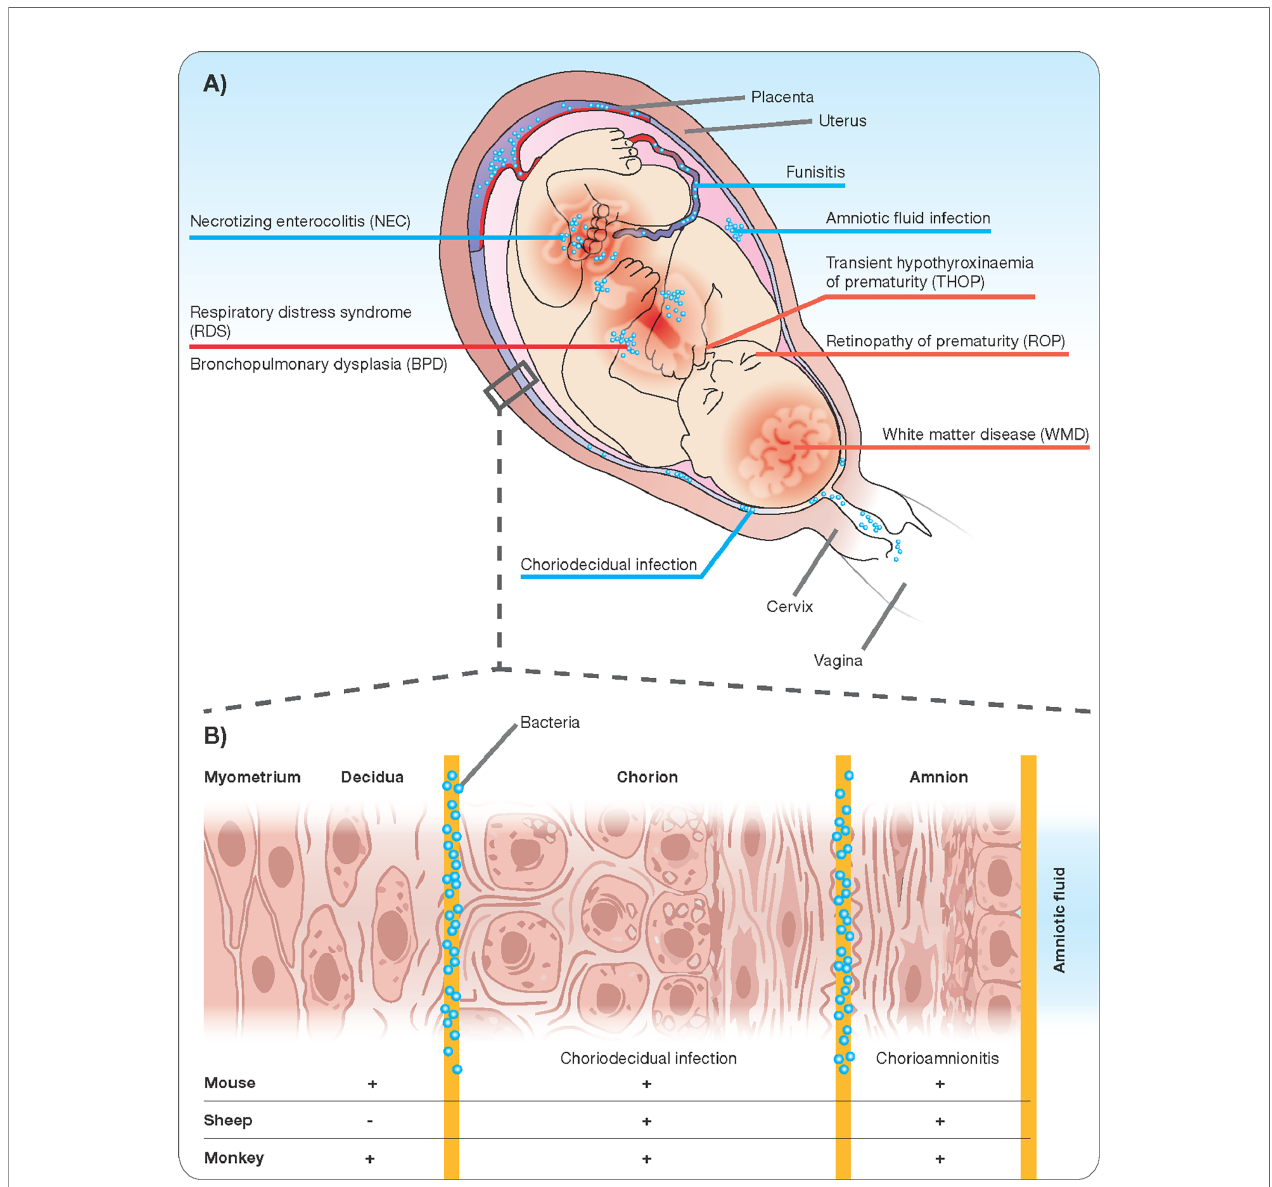
FIGURE 1 | Chorioamnionitis as a multiorgan disease of the fetus (A) with potential sites of infection/in fl ammation (B)